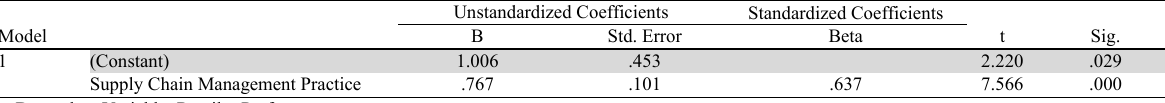
T-test results of supply chain management practice